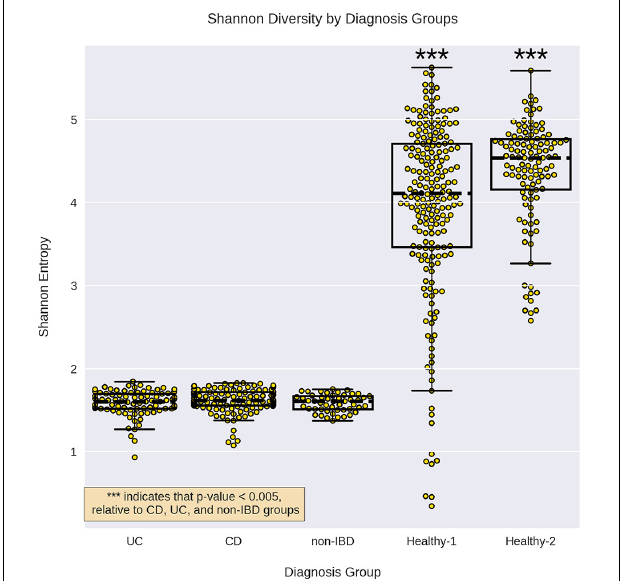
FIGURE 1 | Alpha diversity for the different sample groups. Alpha diversity for each sample group by was calculated using Shannon entropy. The alpha-diversity for CD, UC, and non-IBD were not significantly different from each other but all three were significantly lower than the healthy cohorts. *** indicates a p -value < 0.0005 compared to CD, UC, and non-IBD, using a Mann–Whitney U